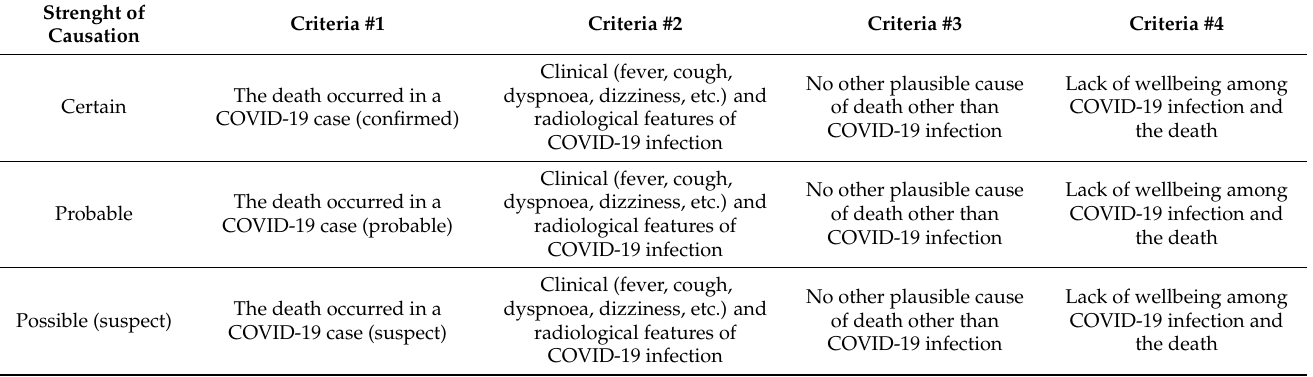
Table 1. Definition of COVID-19-related death according to the Italian Istituto Superiore di Sanit à